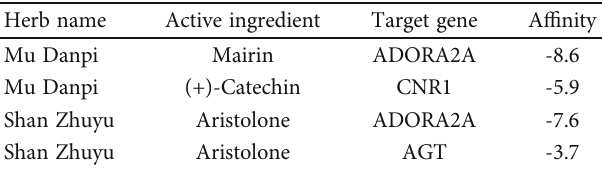
Figure 7: LWDHW-main active compound – GDM-target-signaling pathway network. Brown diamonds represent herbs, blue squares represent ingredients, pink circles represent target genes, and red hexagons represent pathways. The pink circles with red frames represent the pathway-related targets. Table 3: List of the best models for molecular